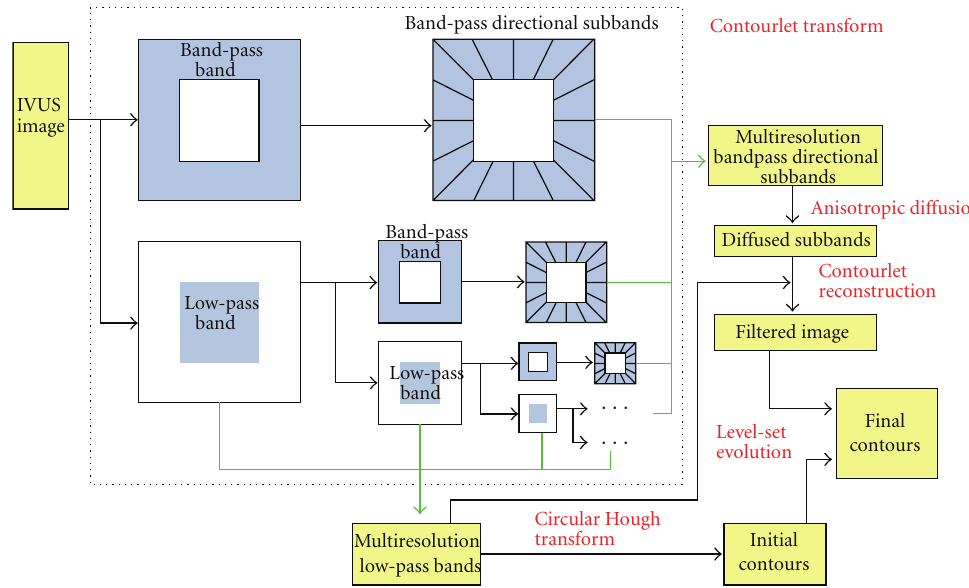
Figure 1: Main framework of contourlet level-set model (contourlet transform shown in dashed